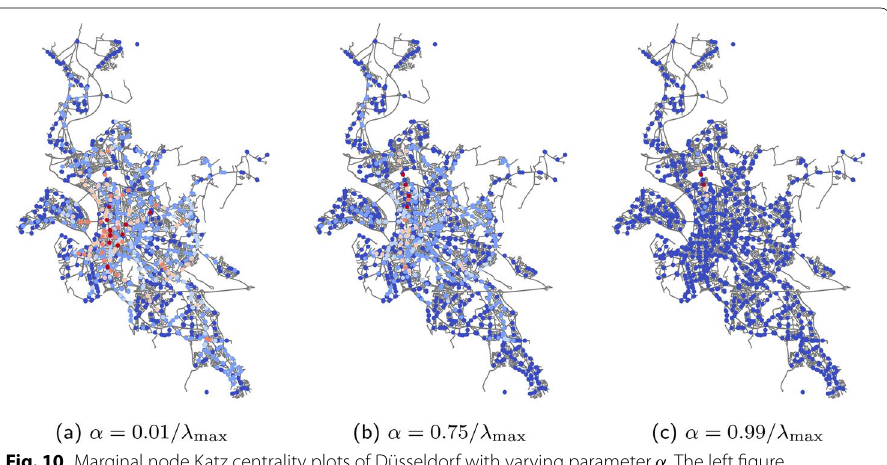
Fig. 10 Marginal node Katz centrality plots of Düsseldorf with varying parameter α . The left figure corresponds to a local measure close to degree centrality, the right figure corresponds to a global measure close to eigenvector centrality, and the center figure corresponds to an interpolated intermediate situation. Central stops are marked red and non-central stops are marked blue. The entries in the supra-adjacency matrix are weighted with travel times and frequencies. The remaining hyper-parameters are chosen as σ = 5 and (cid:31) t transfer = 15 . The street network in the background of the plots is created with the OSMnx